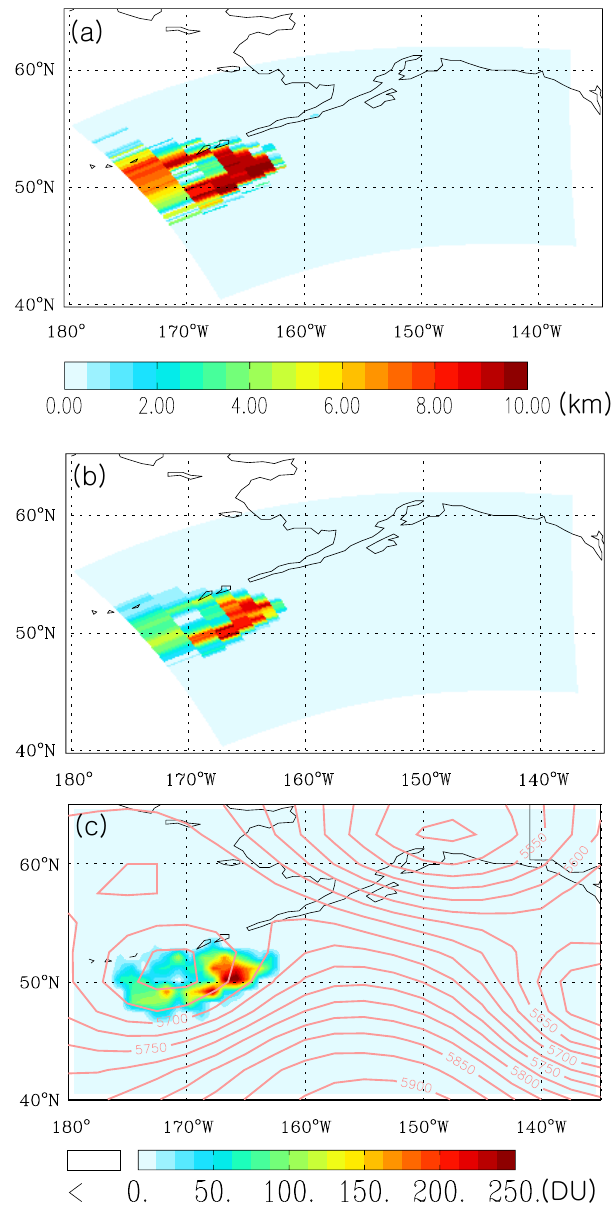
Fig. 1. Kasatochi volcanic SO 2 plume effective height (a) and SO 2 column amount (b) as retrieved by the OMI EISF algorithm at the OMI footprint resolution on 8 August 2008 (Yang et al., 2009, 2010), and the corresponding SO 2 column amount mapped onto the GEOS-Chem grid box (c) . (c) is used to initialize the SO 2 distri- bution in the model. See text for details. The pink solid lines in (c) are isopleths (at 25m intervals) of the 500hPa geopotential height (in m). For illustration purpose, the SO 2 data in (c) is interpolated at 1 ◦ × 1 ◦ resolution, but is gridded into 2 ◦ × 2.5 ◦ resolution in the model